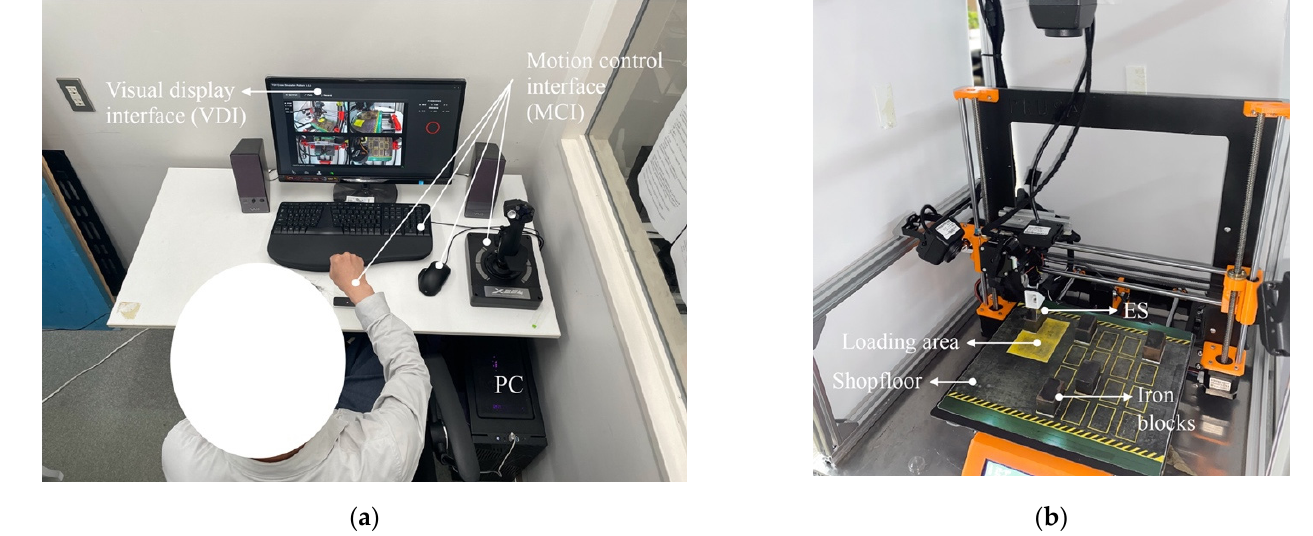
Figure 6. The experiment set-up. ( a ) Teleoperation room (TR). ( b ) The lifting and handling field (LHF).